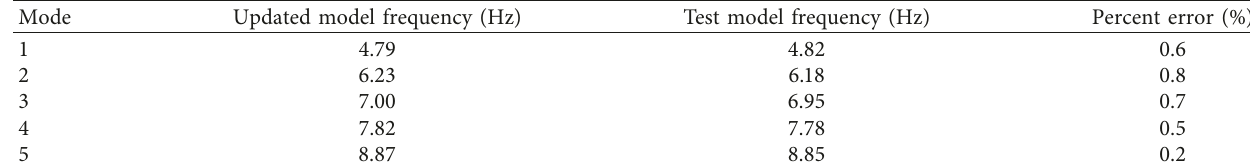
Table 6: Reference and updated model